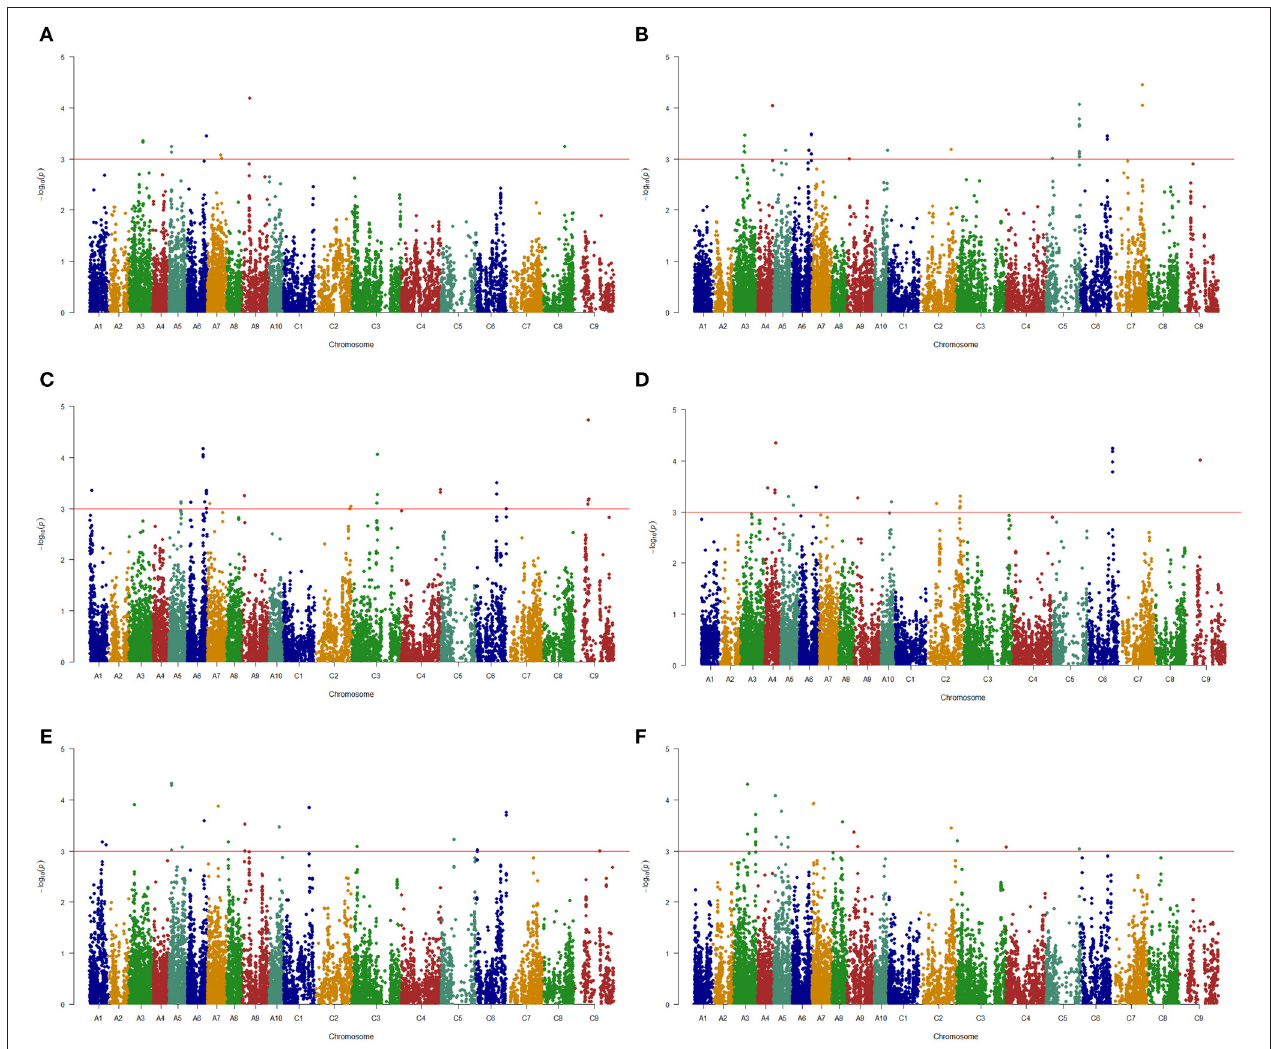
FIGURE 5 | Manhattan plots of association analysis for branch angle using the Q + K model in six environments. (A) E1. (B) E2. (C) E3. (D) E4. (E) E5. (F) E6. The horizontal red line indicates the significance threshold [–log 10 ( p ) =